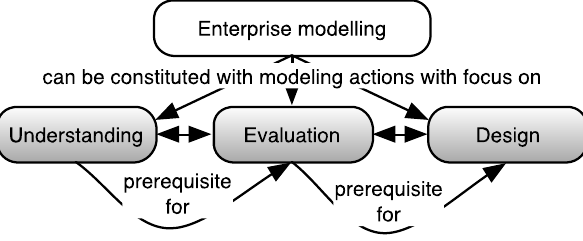
Figure 8. Conceptualization of the process dimension